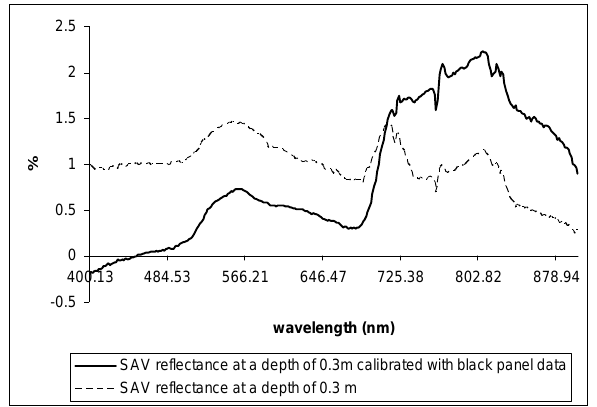
Figure 8 : An example of the original reflectance of SAV compared the same data corrected with the black panel data at the same depth.